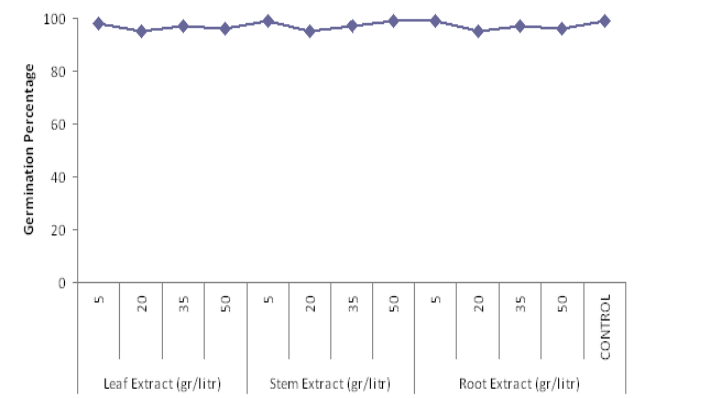
Fig. 1. The effect of sorghum extract on mung bean seed germination